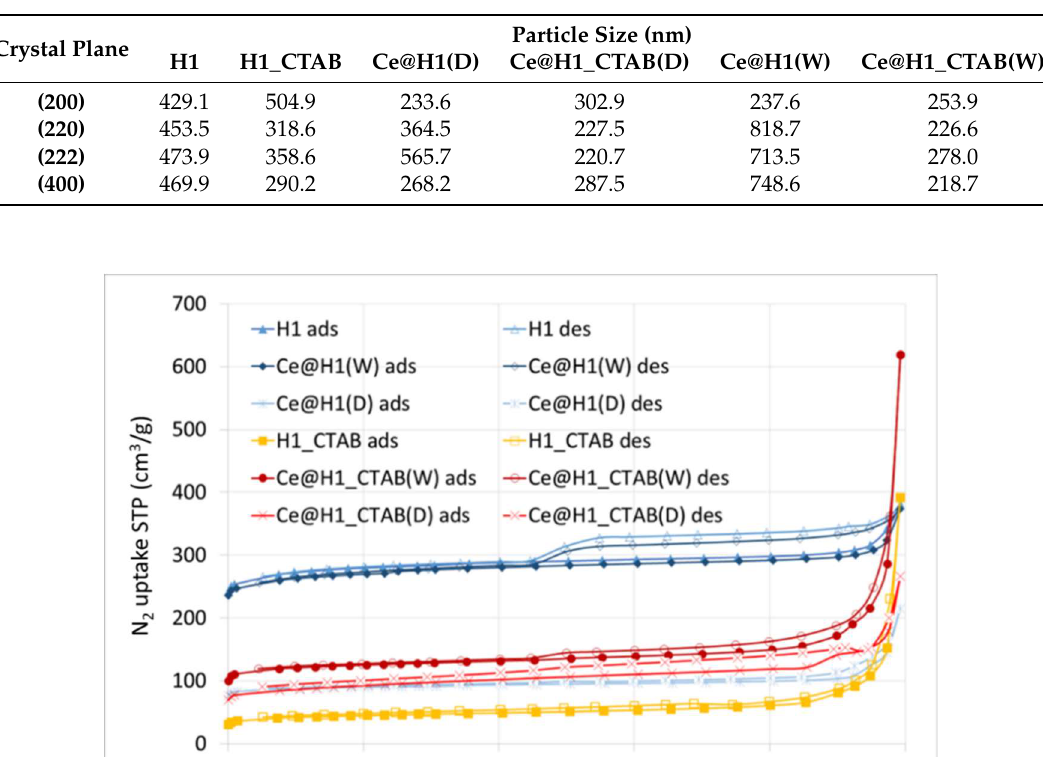
Table 1. Particle size for HKUST-1 and Ce@HKUST-1 materials calculated for (200), (220), (222), and (400) reflexions.